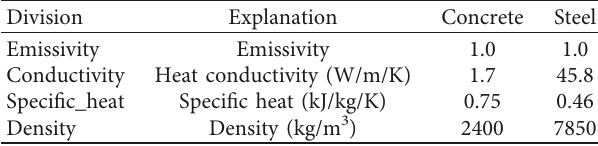
Table 8: MATL input of bridge [28, 29, 30].